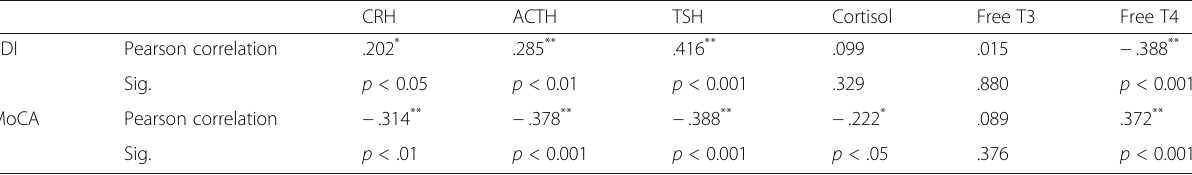
Table 4 Correlations between serum hormonal levels and BDI score, and MoCA score in patients with